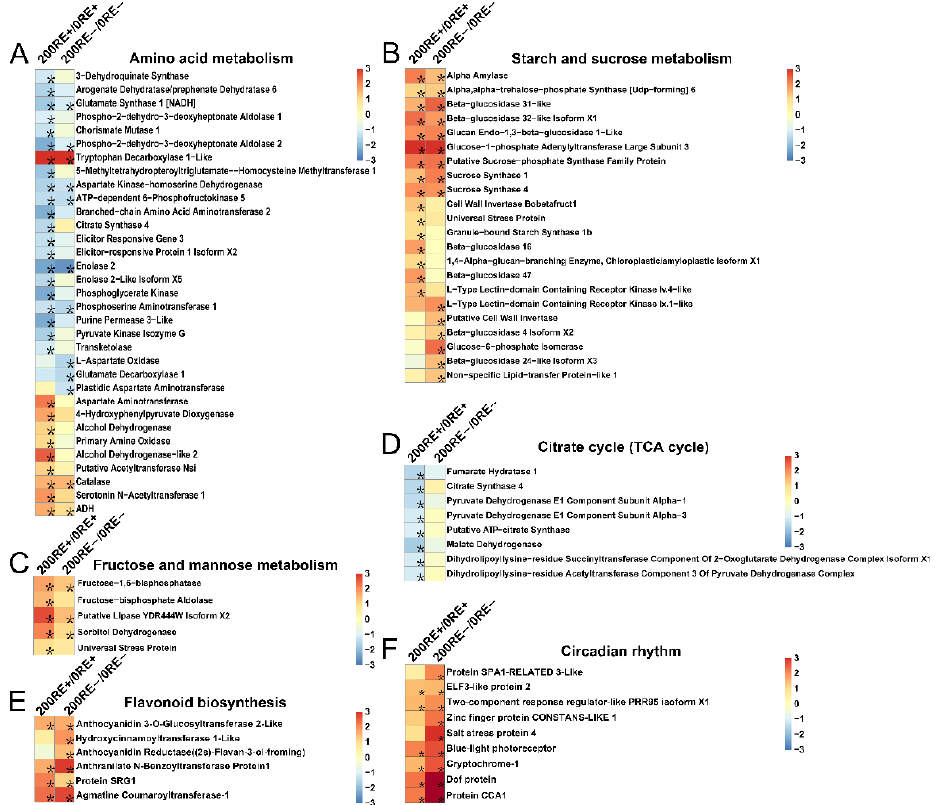
Figure 6. Impact of 200 mM NaCl on amino acid metabolism ( A ), starch and sucrose metabolism ( B ), fructose and mannose metabolism ( C ), citrate cycle ( D ), flavonoid biosynthesis ( E ) and circadian rhythm ( F ) in roots of E+ and E − A. inebrians . Color panels stand for log 2 (fold change). Asterisks indicate statistically significant changes with FDR < 0.01 and fold change ≥